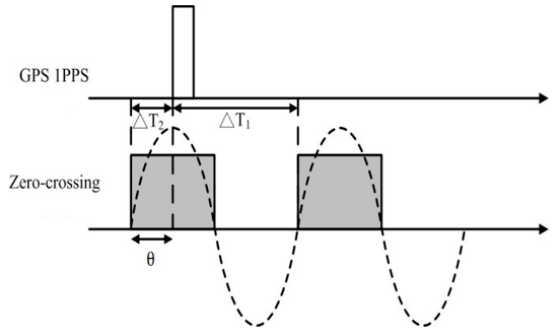
Figure 3. Method to measure voltage angles.